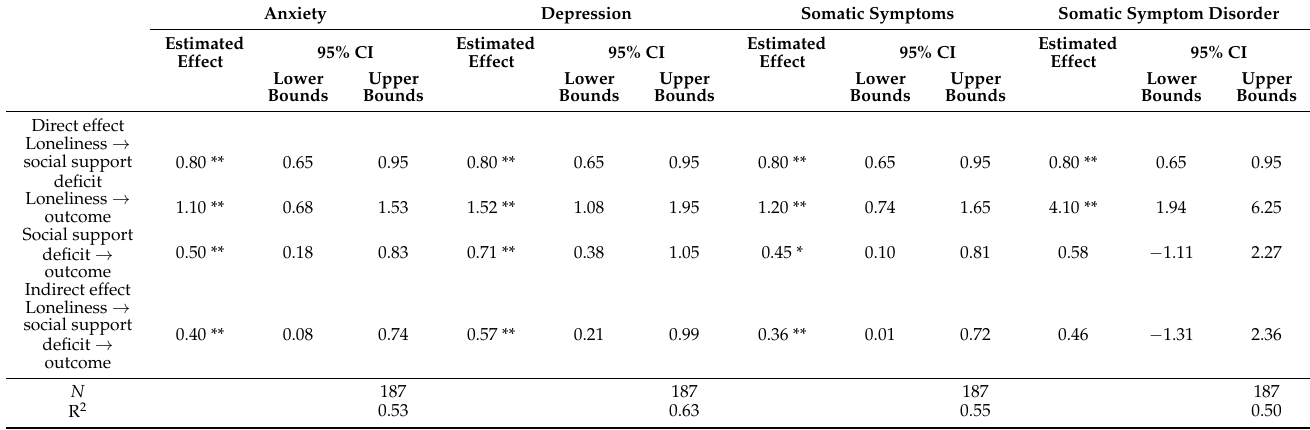
Table 3. Direct and indirect effects and 95% confidence intervals for the mediation analyses after inclusion of the covariates.